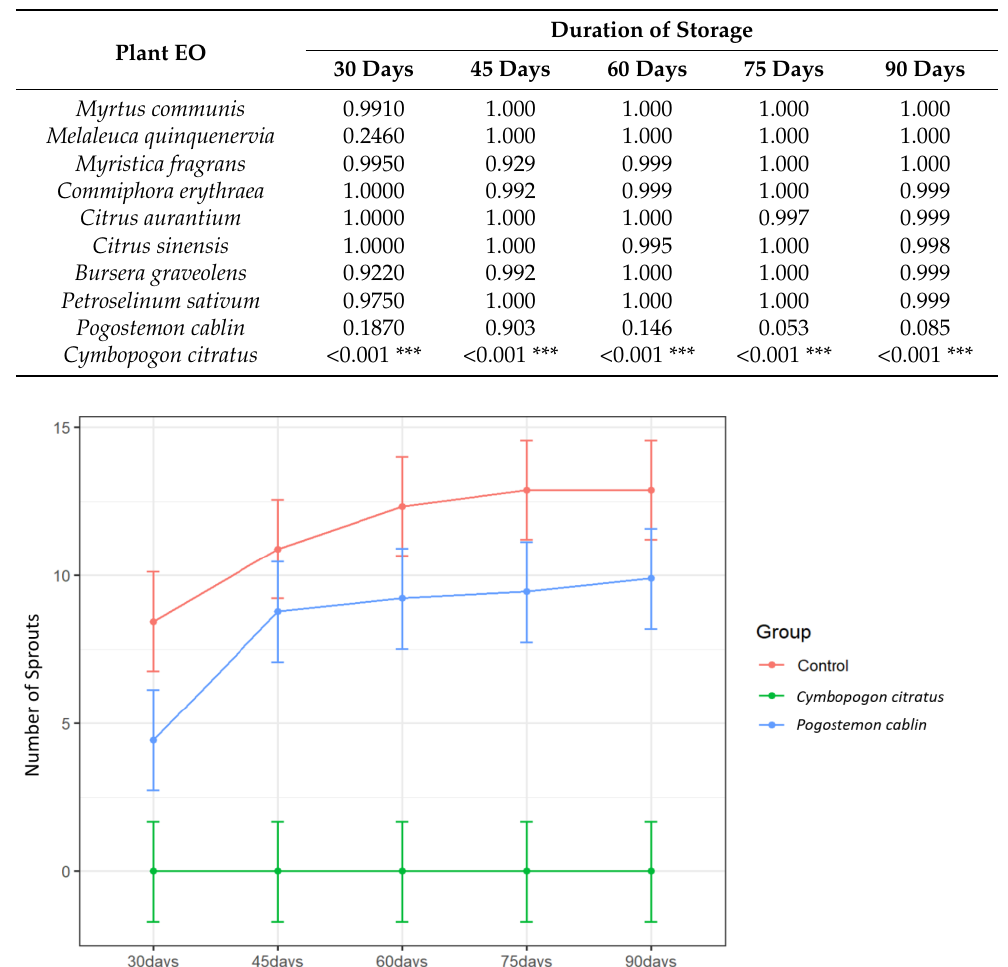
Table 7. Tukey’s test p -values describing the essential oils (EOs’) effects on sprout number relative to the control at all time points (*** = statistically significant).